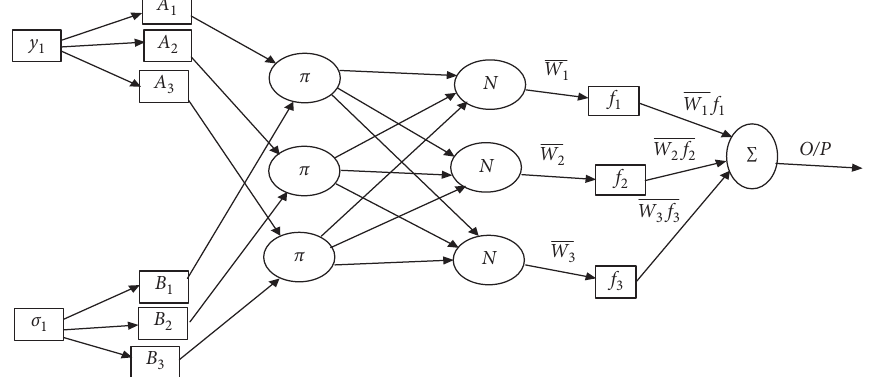
Figure 2: Architecture of the fuzzy-EGARCH-ANN model with p � 1, q � 1, m � 1, s � 1, and R �